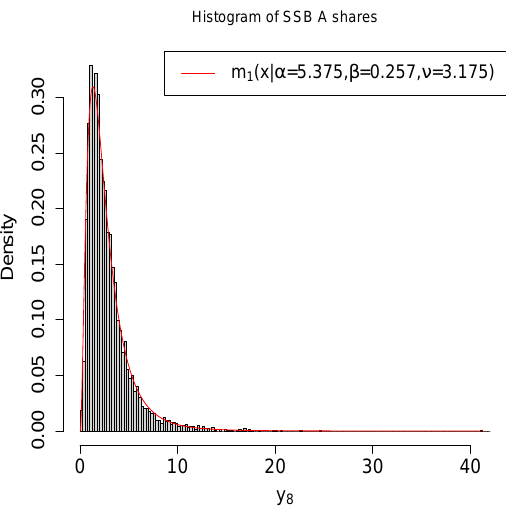
Figure 12. The histogram of the transformed data y m 1 ( x | α = 5.375, β = 0.257, ν = 3.175 )